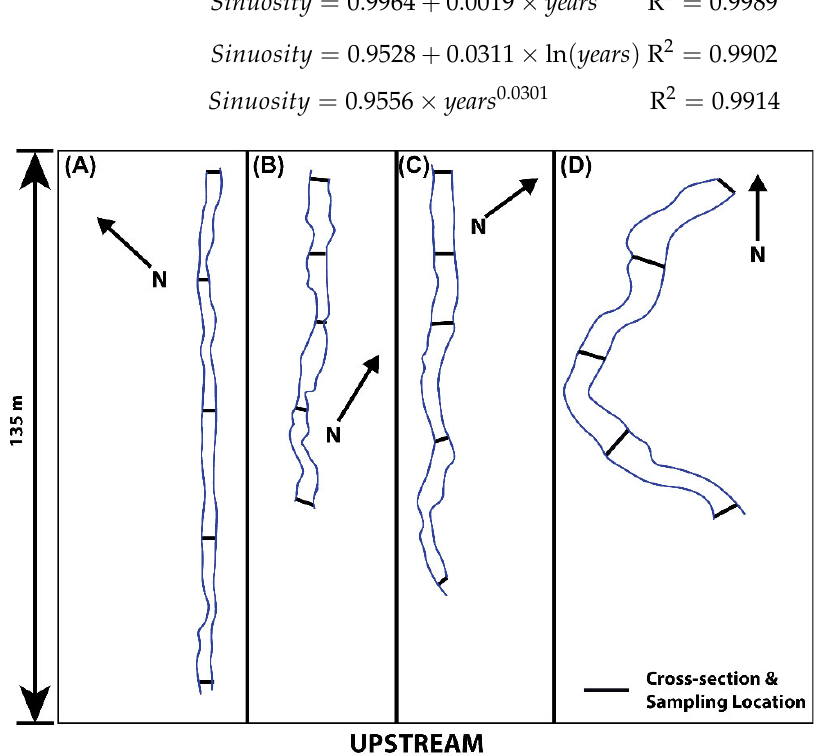
Figure 3. Plan view of the surveyed stream profiles of the four study reaches. ( A ) 1900N; ( B ) Frog Creek—7 years; ( C ) Bray Creek; ( D ) Crooked Creek. Scale along the left (y-) axis is consistent for both horizontal dimensions.